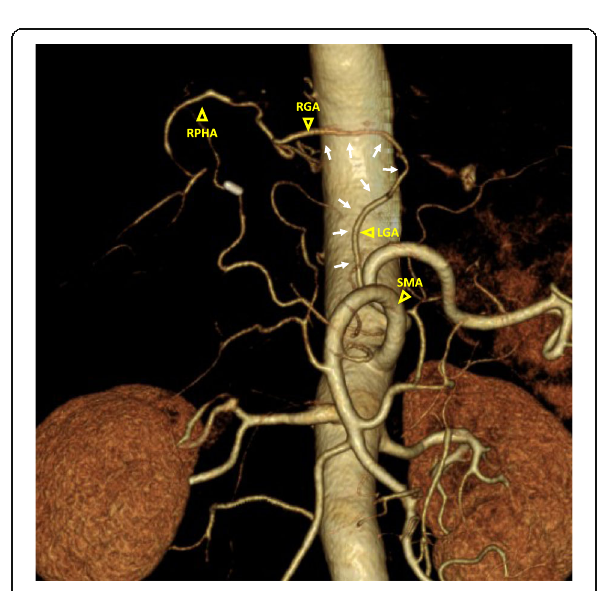
Fig. 4 A postoperative three-dimensional CT angiogram. The gastric arterial arcade is shown (white